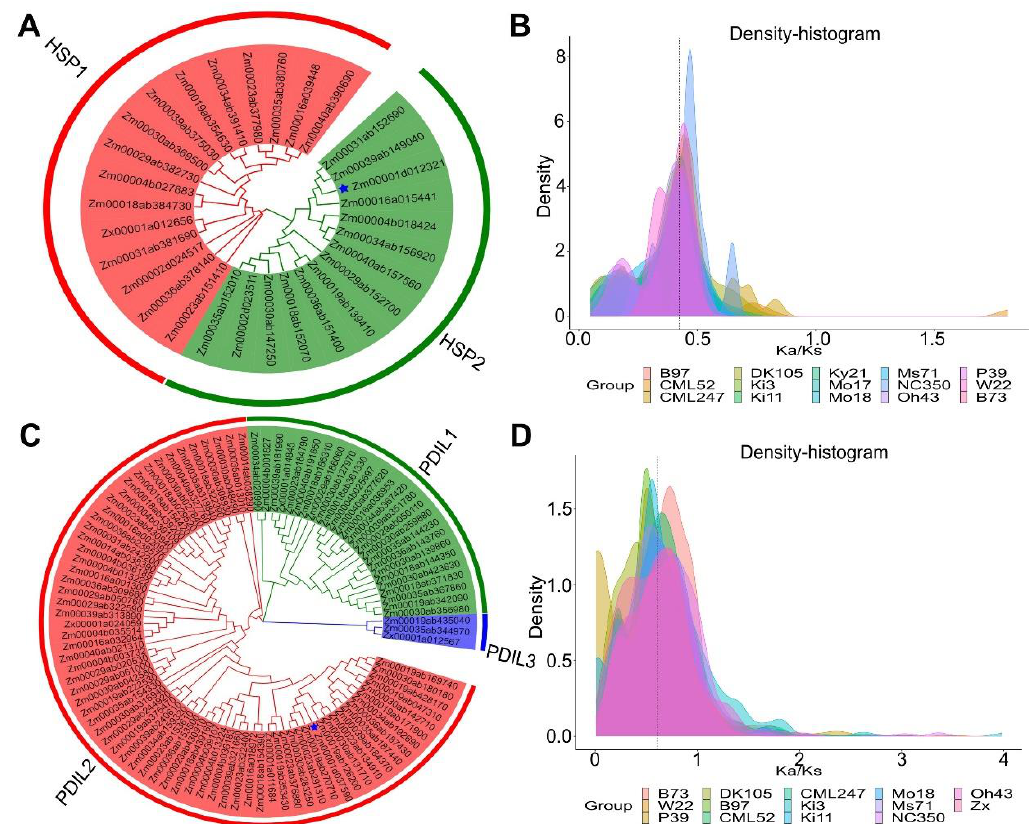
Figure 7. ( A ) Phylogenetic tree of homologous genes in Zm00001d012321 . ( B ) Analysis of homologous gene selection pressure in Zm00001d012321 . ( C ) Phylogenetic tree of homologous genes in Zm00001d037590 . ( D ) Analysis of homologous gene selection pressure in Zm00001d037590 .